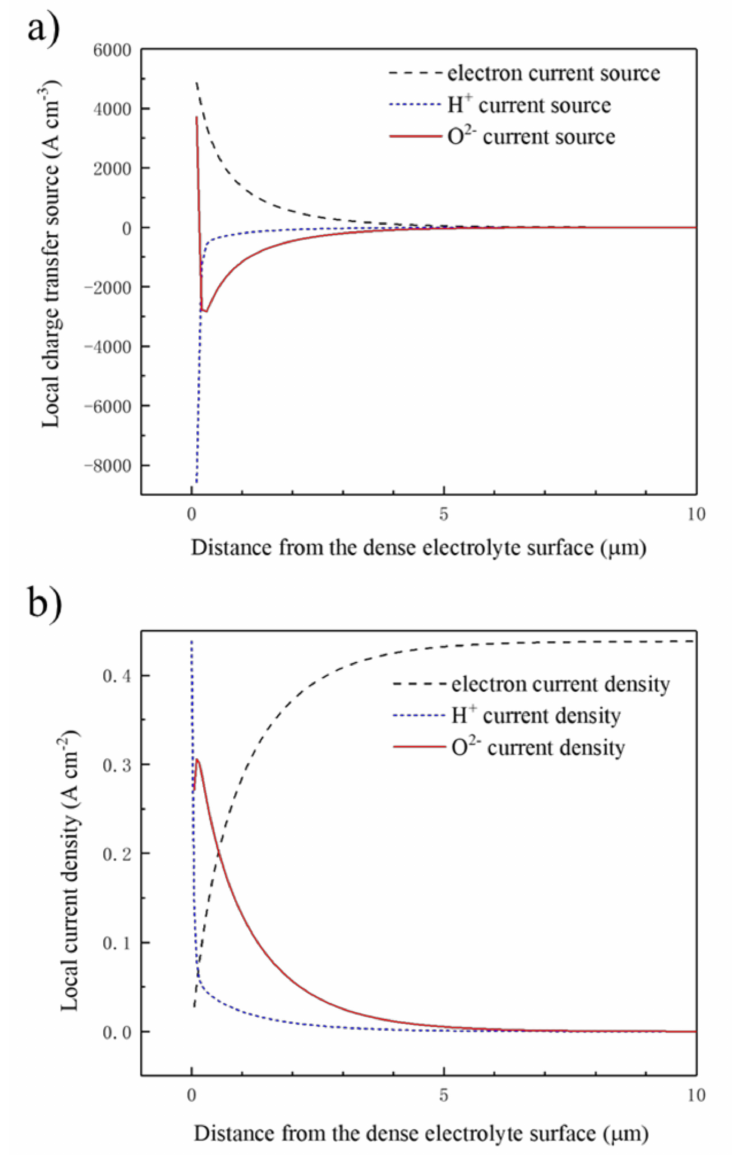
Figure 4. The distributions of ( a ) the local e − , O 2 − , and H + electric charge transfer source in the PCFC cathode. ( b ) The local e − , O 2 − , and H + electric current densities in the